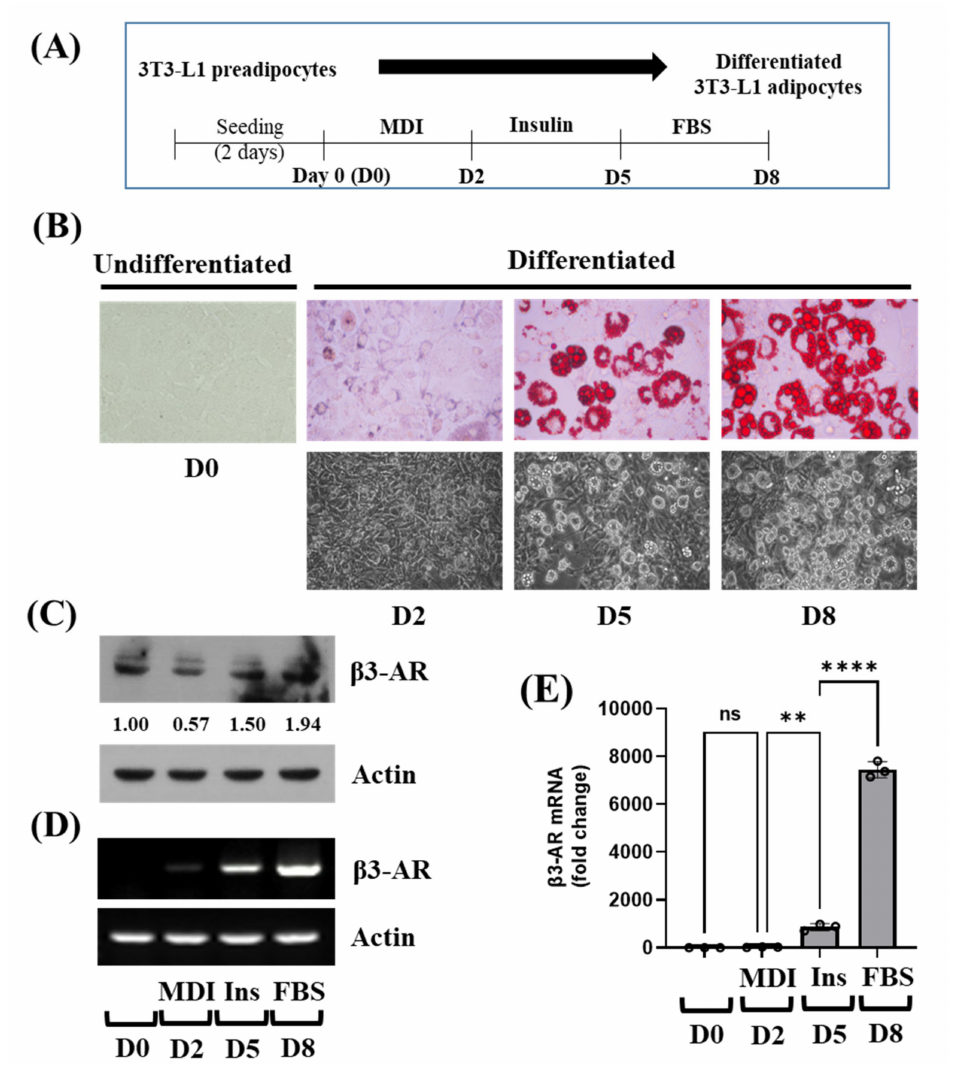
Figure 1. Lipid accumulation and expression of β 3-AR at the protein and mRNA levels during 3T3-L1 preadipocyte differentiation. ( A ) The scheme for 3T3-L1 preadipocyte differentiation. ( B ) Measure- ment of lipid droplets (LDs) accumulation on day 0 (D0), D2, D5, and D8 of 3T3-L1 preadipocyte differentiation by Oil Red O staining (upper panels) and by phase-contrast image (lower panels). ( C ) 3T3-L1 preadipocytes were differentiated with an induction medium containing MDI, insulin, and FBS, and harvested at D0, D2, D5, and D8, respectively. At each time point, whole-cell lysates were prepared and analyzed by immunoblot analysis with respective antibodies. Relative intensities were measured by ImageJ software (version 1.8.0; National Institutes of Health). ( D – E ) 3T3-L1 preadipocytes were differentiated with an induction medium containing MDI, insulin, and FBS, and harvested at D0, D2, D5, and D8, respectively. At each time point, total cellular RNA was extracted and analyzed by RT-PCR ( D ) or real-time qPCR ( E ) with respective primers. In ( E ), Error bars are indicated as mean ± SD. ** p < 0.01; **** p < 0.0001; ns, not significant, calculated by one-way ANOVA with Sidak’s multiple comparison